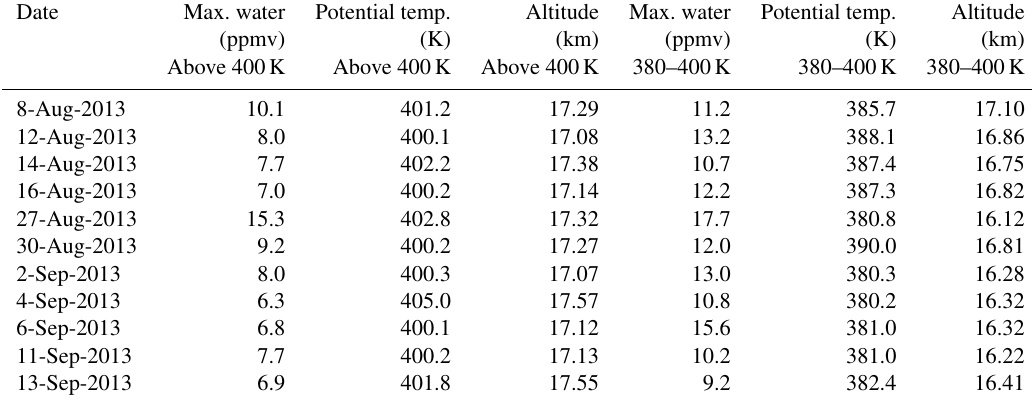
Table 1. A summary of the enhanced water vapor measurements in the overworld stratosphere during SEAC 4 RS ∗ . The dates are NASA ER-2 aircraft flight dates in day-month-year format, and the JLH Mark2 maximum water vapor mixing ratios (ppmv) are shown for potential temperatures greater than 400K (left) and in the range of 380–400K